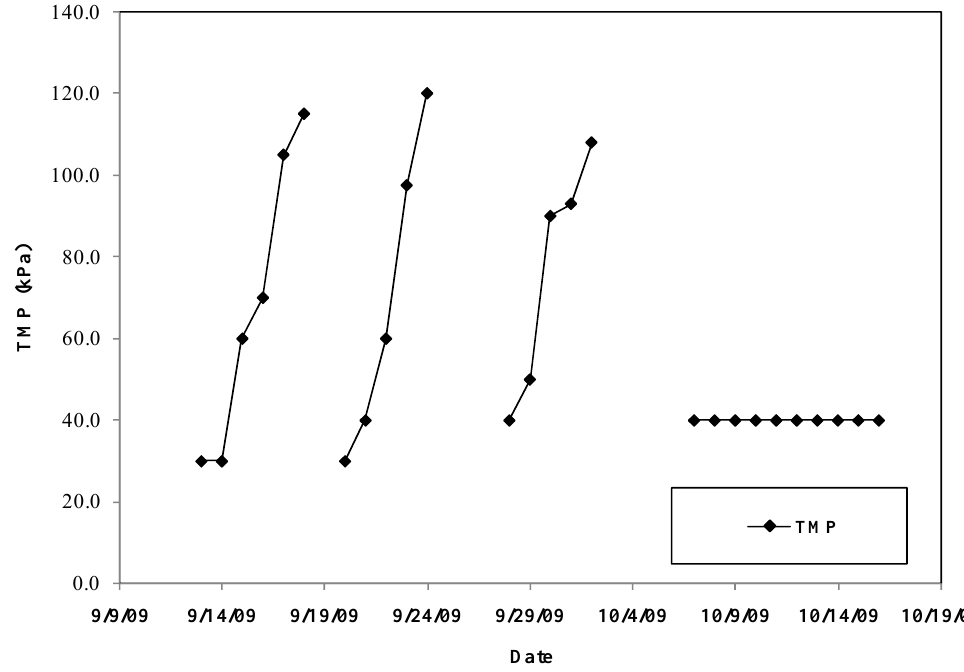
Figure 3. Variation of the daily average MP data over time calculated according to equation